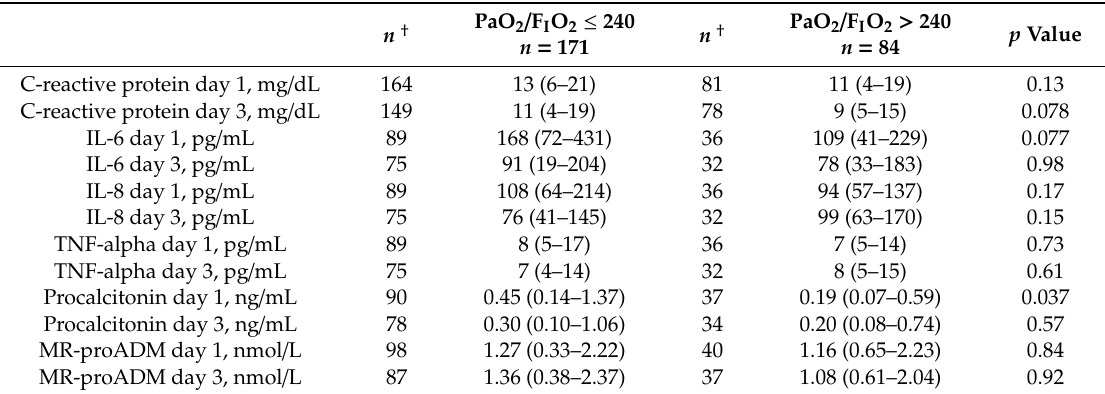
* Results are given as median (inter-quartile range). † Number of cases with blood samples processed for each inflammatory biomarker and group. Definition of abbreviations: IL: interleukin; TNF: tumor necrosis factor; MR-proADM: mid-regional